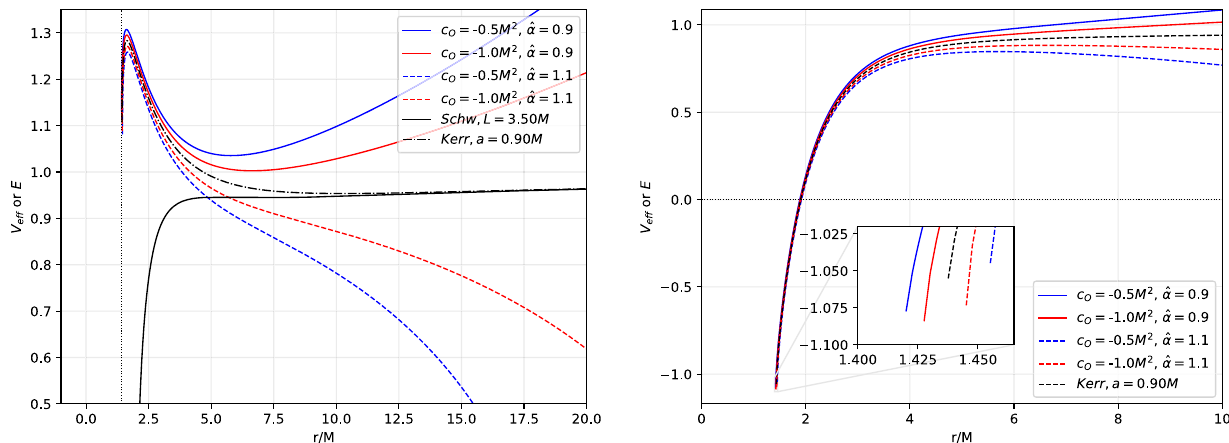
Fig. 6 The effective potential as a function of r / M for L > 0 (left-panel) and L < 0 (right-panel). In both plots, the black hole spin parameter is set to a = 0 . 90